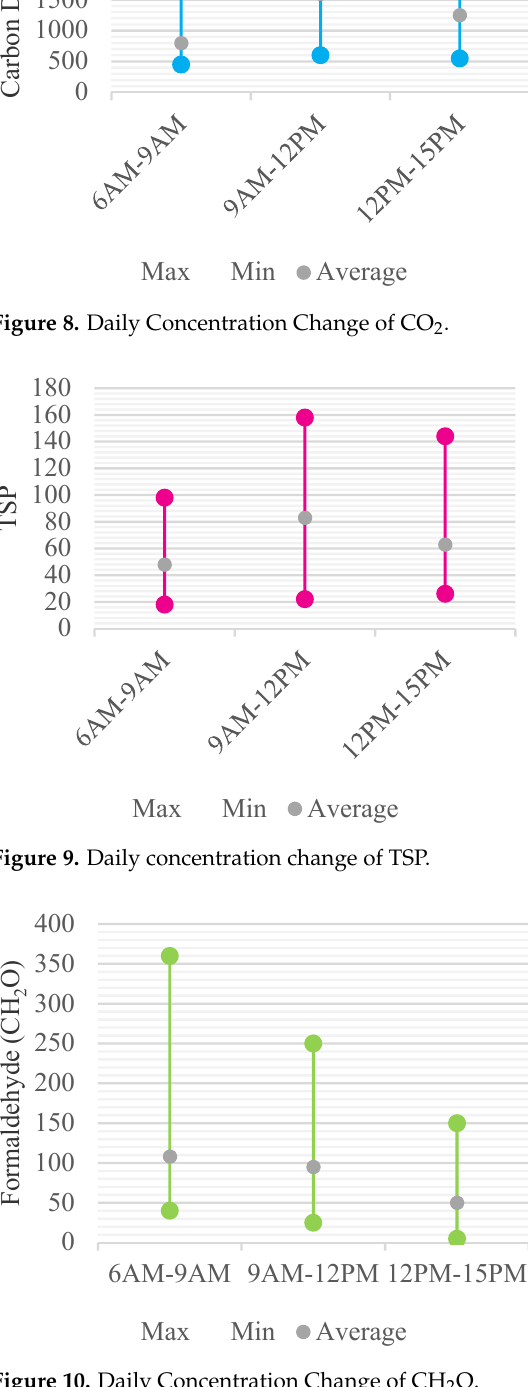
Figure 10. Daily Concentration Change of CH 2 O.